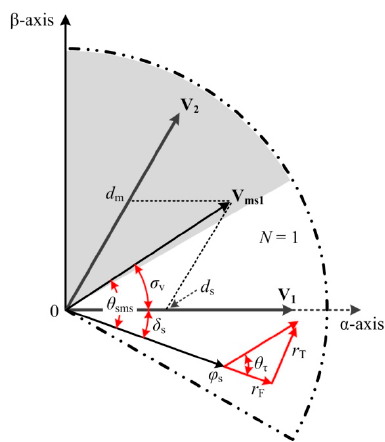
Figure 3. Relationships of variables in the control system.